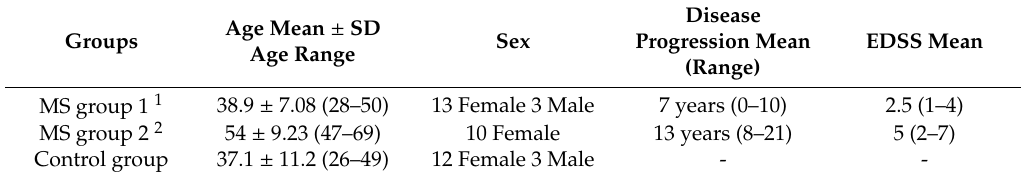
Table 1. Demographic data of multiple sclerosis (MS) and healthy control group.